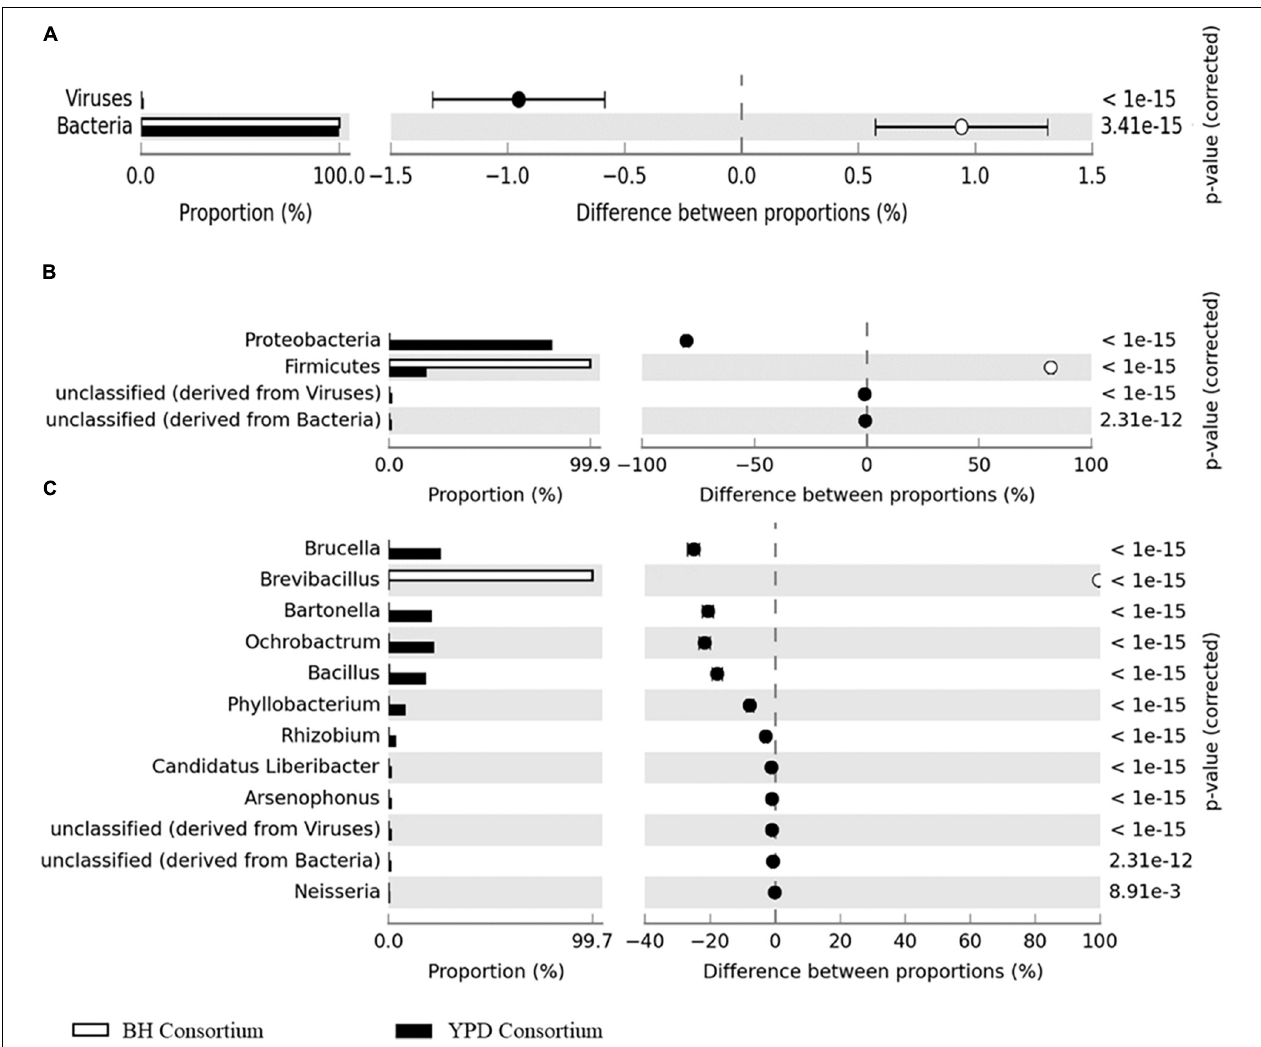
FIGURE 3 | Differences in taxonomic profiles between consortia. (A) Domain; (B) Phylum; and (C) Genus levels. q < 0.05 was considered statistically significant, using the two-sided Fisher’s exact